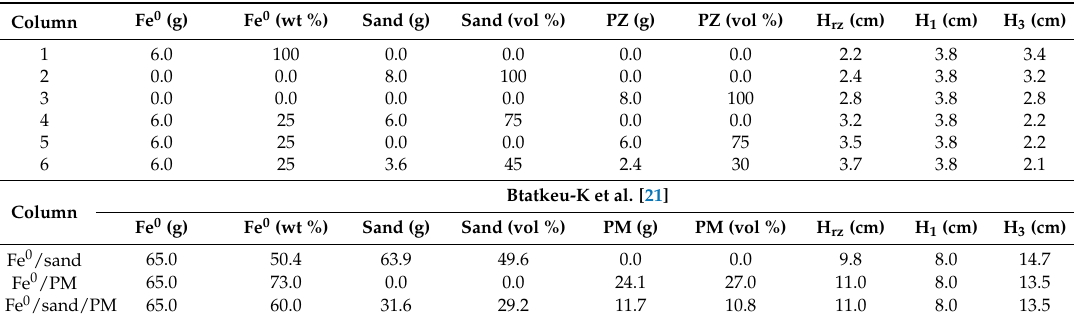
Table 2. Overview of the experimental setup of the column experiments. H rz is the reactive zone, while H 1 and H 3 , respectively, represent the bottom and the top sand layers of the systems. This table particularly shows the composition of the reactive zone (RZ) of individual systems. Columns 1, 2, and 3 (pure materials) were reference systems. The operational conditions for the Fe 0 /sand/PM (PM = pumice) system of Btatkeu-K et al. [21] are also